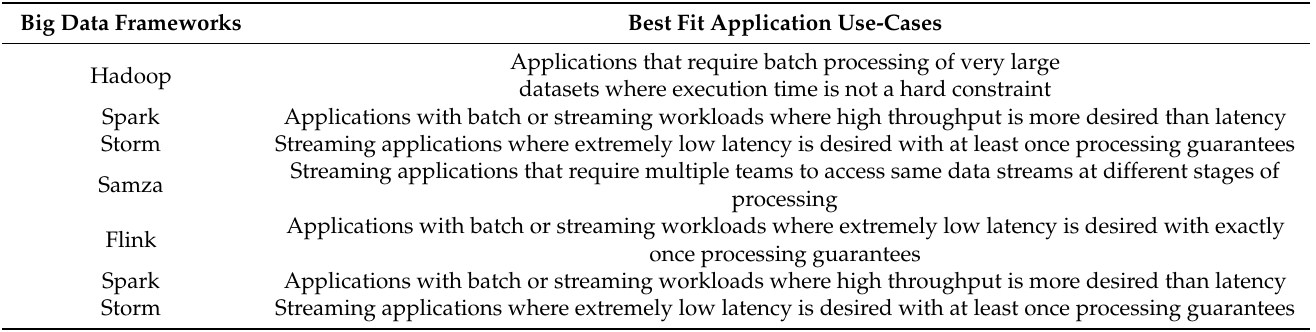
Table 10. Application use cases where each of the frameworks ideally fits in. Big Data Frameworks Best Fit Application